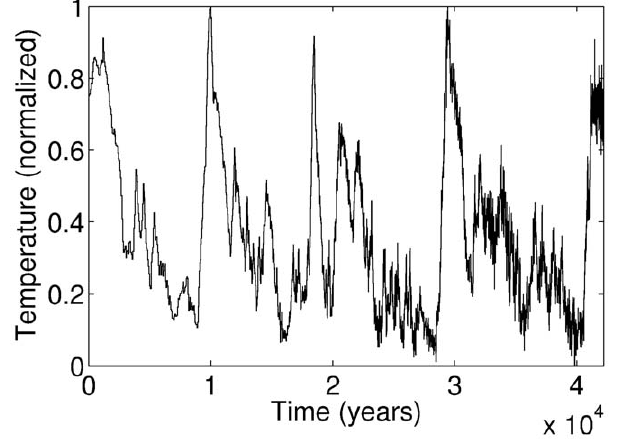
Figure 3. The Vostok ice core data. Long periods of cooling are punctuated by rapid deglaciation.